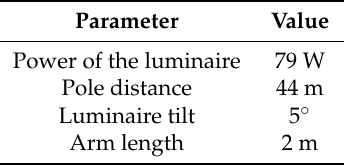
Table 5. Optimized pole distance and luminaire position for Case A.